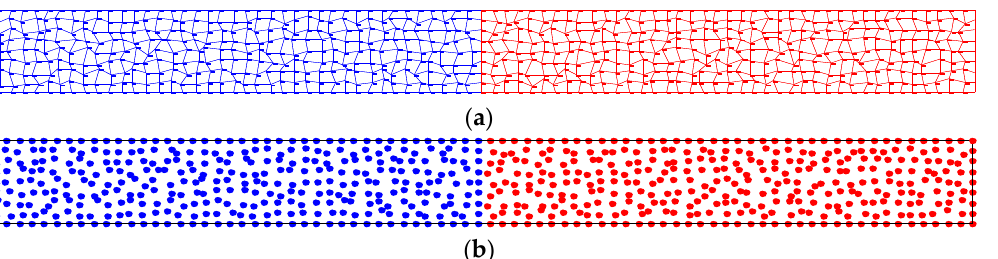
Figure 11. The employed irregular node distributions for the two-dimensional tube: ( a ) FEM-Q4; ( b ) RPIM.